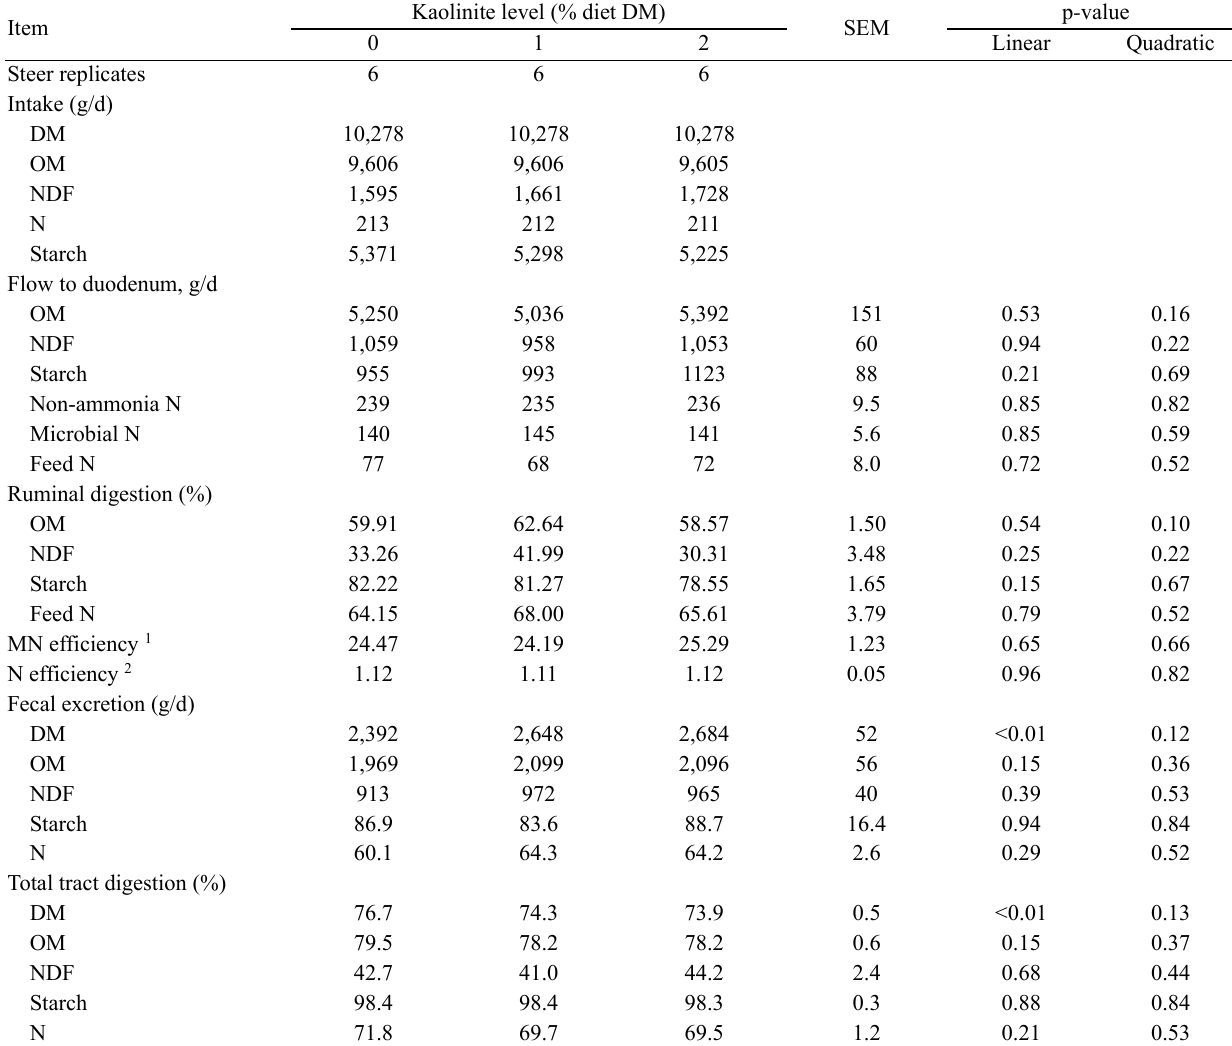
Table 2. Influence of supplementation level of kaolinite clay on characteristics of apparent ruminal and total tract digestion in Holstein steers Item